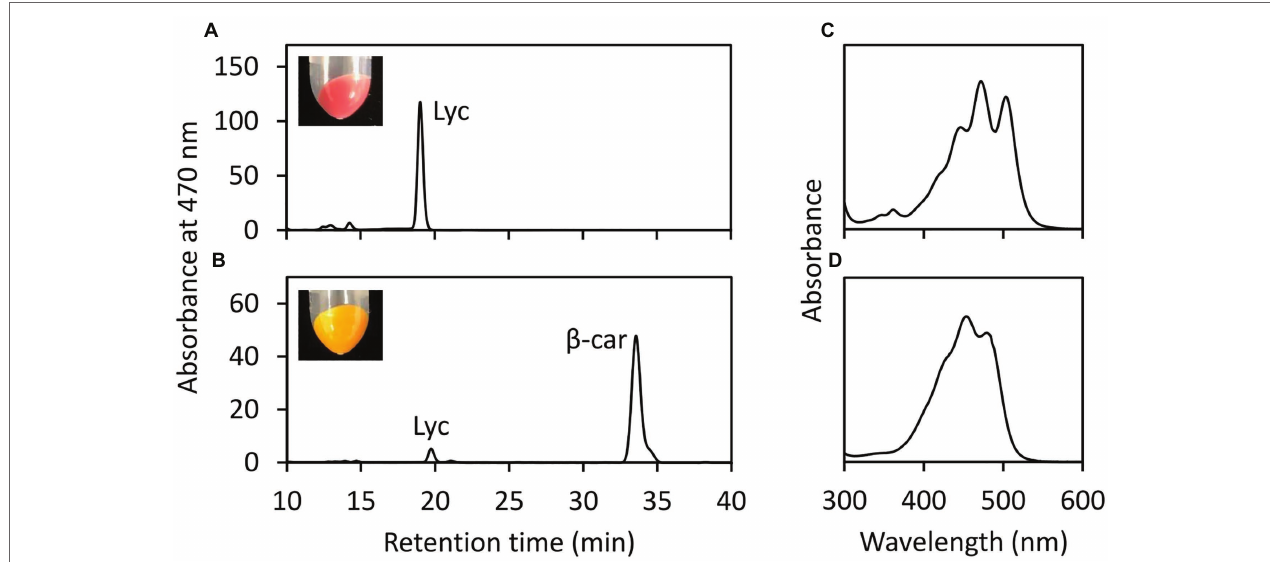
FIGURE 2 | In vivo EgLCY enzyme assay in E. coli cells. HPLC chromatogram (470 nm) of carotenoid extracts of lycopene-accumulating E. coli cells transformed with pETDuet-1 empty vector (A) and pET-EgLCY plasmid (B) . Insets are photographic images of E. coli pellets. Absorbance spectra of detected peaks of lycopene (C) and β -carotene (D) . Lyc, lycopene; β -car, β